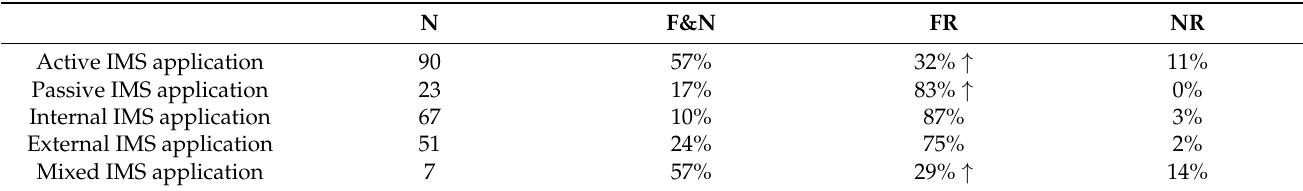
Table 15. Databases analyses of the ideas